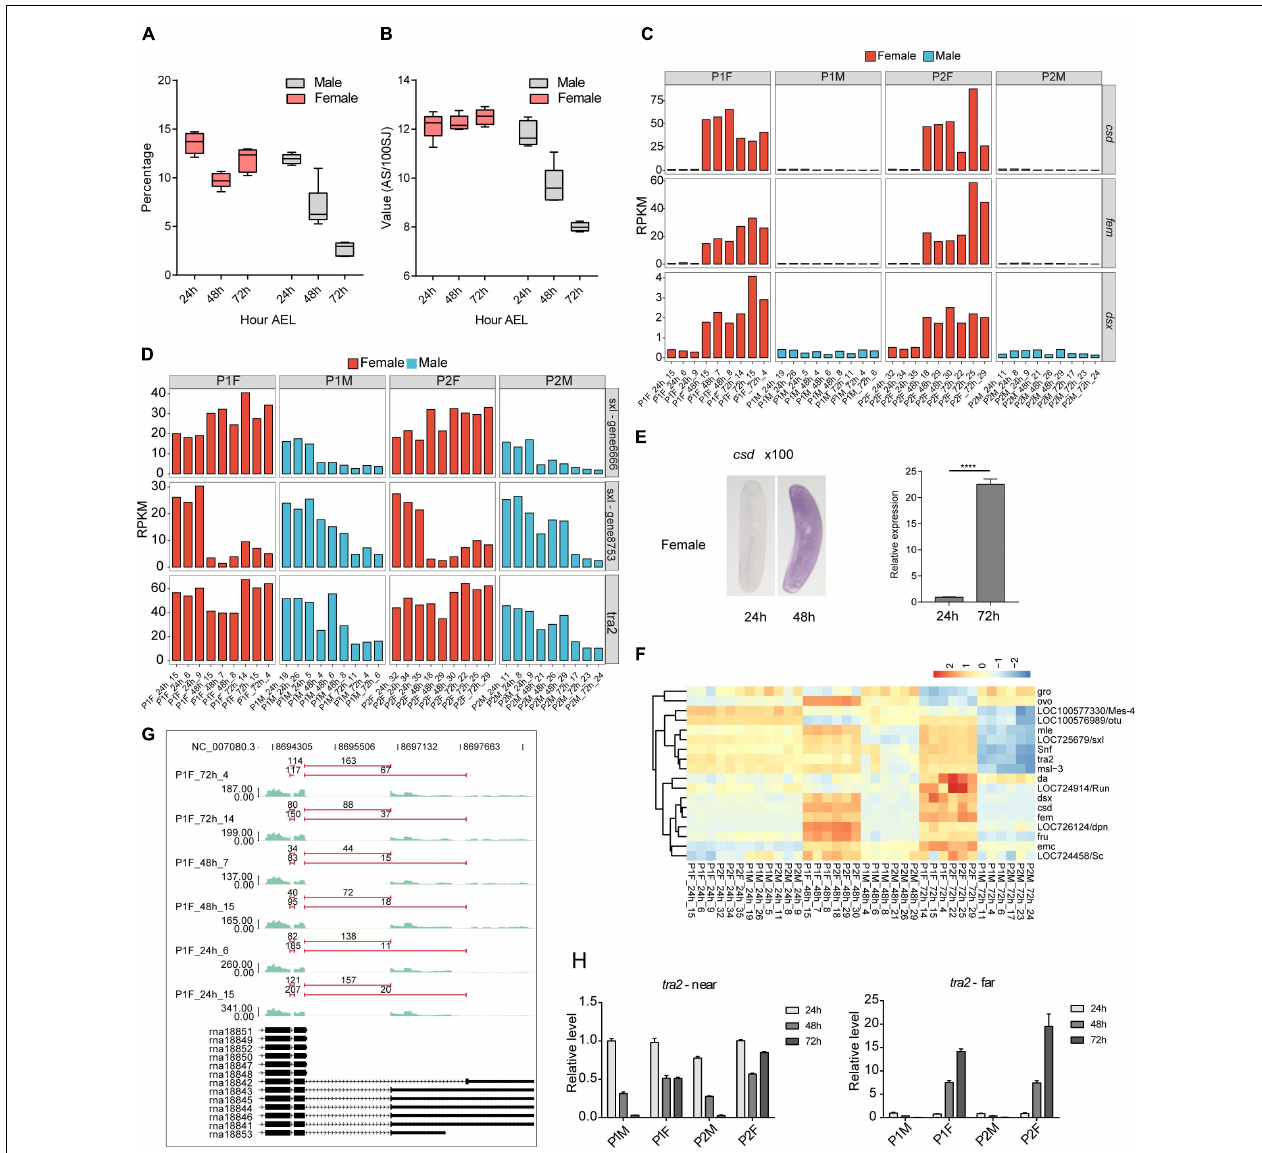
FIGURE 4 | Alternative splicing (AS) is regulated in a sex-specific pattern during honeybee embryonic development. (A) Boxplot showing the percentage of spliced reads among total uniquely mapped reads for each group. (B) Boxplot showing the detection efficiency of AS events in female and male eggs. We used the detected ASEs number per 100 SJs as the detection efficiency. (C) Bar plot showing the time-dependent expression dynamics of Sxl , tra , and dsx in male and female embryos. (D) Bar plot showing the time-dependent expression dynamics of tra2 and two copies of Sxl in male and female embryos. (E) ISH and RT-qPCR validation results of the increased expression level of csd gene after 24 h AEL in female embryos. The embryos were amplified by 100 times, and the purple color represented the intensity signal of csd (ISH, left). (F) Hierarchical clustering heatmap of the expression level of SDGs revealed two types of expression patterns: maternal expressed (upper cluster) and zygotic activated (lower cluster) (G) Reads density plot showing the APA regulation of tra2 transcripts in female embryos. The numbers above the red line indicate the counts of splicing junction reads. (H) Bar plot showed the RT-qPCR validation of APA usage for tra2 transcripts. Left panel showing the proximal PAS signal, and right panel for distal PAS